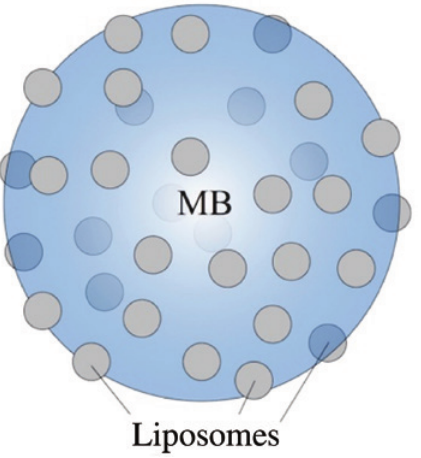
Figure 11: Potential ability of microbubbles to carry a large number of liposomes and, hence, increasing the drug loading capacity (see